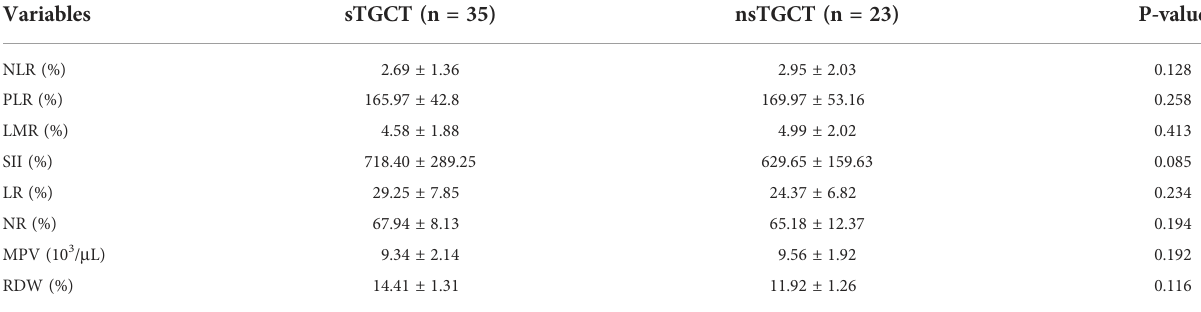
NLR, neutrophil/lymphocyte ratio; PLR, platelet/lymphocyte ratio; LMR, lymphocyte/monocyte ratio; SII, systemic immune-in fl ammation index; LR, lymphocyte ratio; NR, neutrophil ratio;MPV,meanplateletvolume;RDW,redcelldistribution;CBC,completebloodcount;sTGCT,seminomatoustesticulargermcelltumors;nsTGCT,non-seminomatoustesticulargerm cell